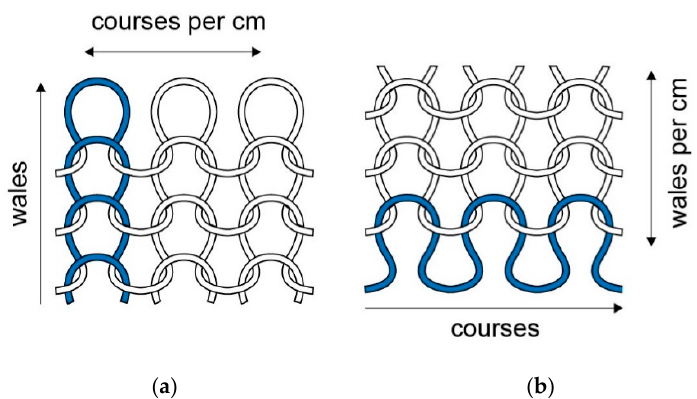
Figure1. Singlejerseyknitstitchshowing( a )courseand( b )waledirectionandtheirdensity(numberper Figure 1. Single jersey knit stitch showing ( a ) course and ( b ) wale direction and their density (number unit per unit length).